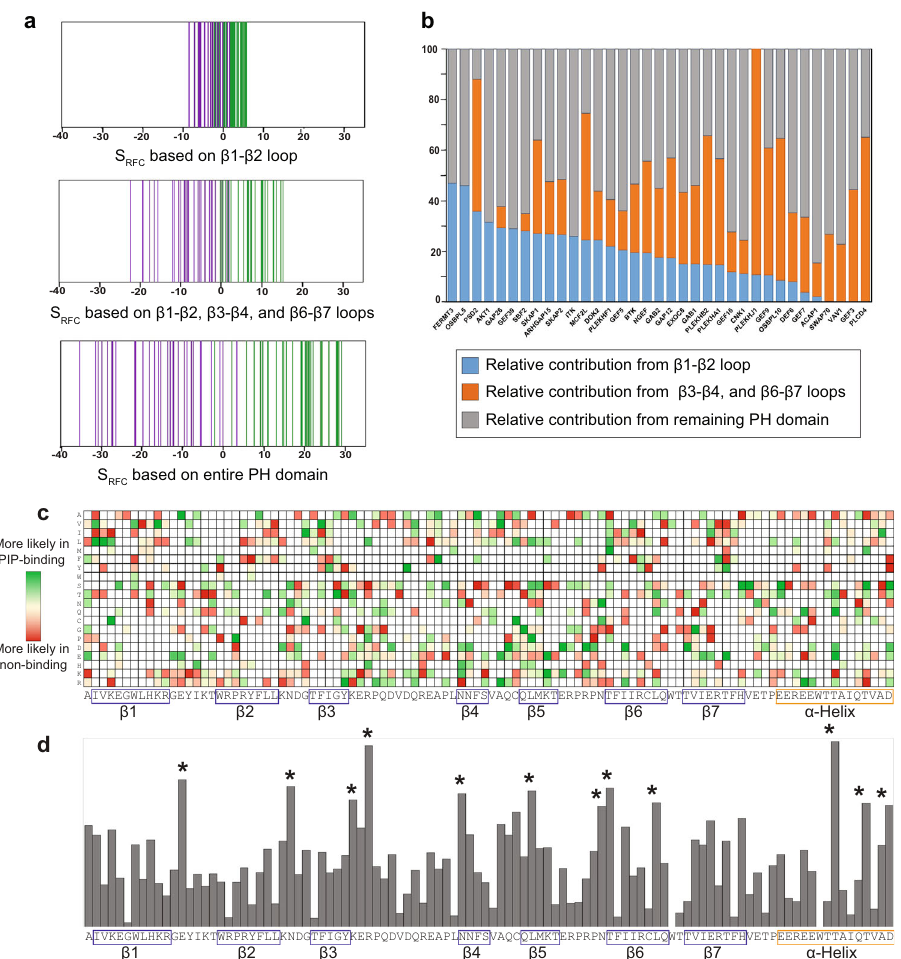
Fig. 6 Recursive-learning algorithm distinguishes PIP-binding when taking the entire PH domain into consideration. a S RFC scores were calculated for the 67 PH domains in our assays, with amino acids from β 1 – β 2 variable loop, β 1 – β 2, β 3 – β 4, β 6 – β 7 variable loops, or the entire PH domain. Each vertical line represents one PH domain. Green: bound PIP in SiMPull assays; purple: did not bind PIP in SiMPull assays. b Relative contribution by β 1 – β 2 loop, β 3 – β 4, and β 6 – β 7 loops, or the rest of the PH domain is plotted based on S RFC for each protein that bound PIP in SiMPull assays. c A heat map showing the contribution of 20 amino acids at each position for the 67 PH domains. The amino acid positions are aligned to AKT1-PH domain based on its crystal structure (PDB ID: 1UNP 27 ). d Contribution from different positions of PH domain towards PIP-binding was plotted from RFC-matrix. Twelve positions with the highest scores are marked by stars and aligned to the sequence in ( c ). Source data are provided as a Source Data fi